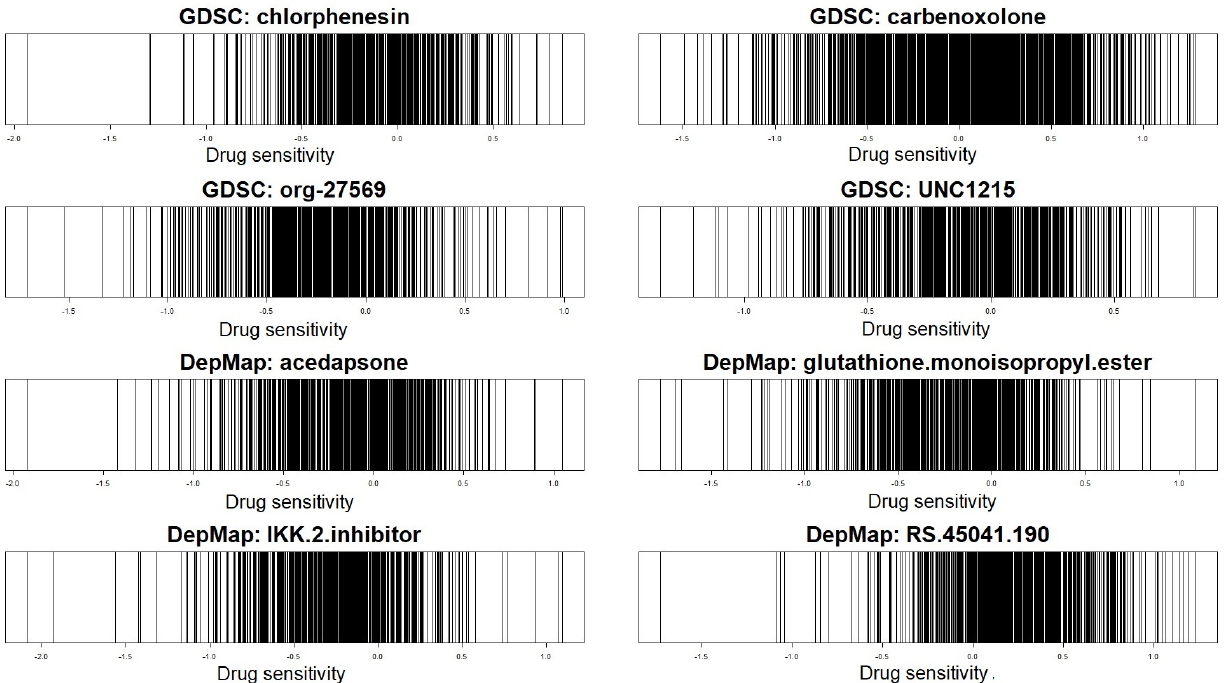
Figure 1. Drug sensitivities of GDSC and DepMap databases: each of the four drugs are randomly selected from GDSC and DepMap